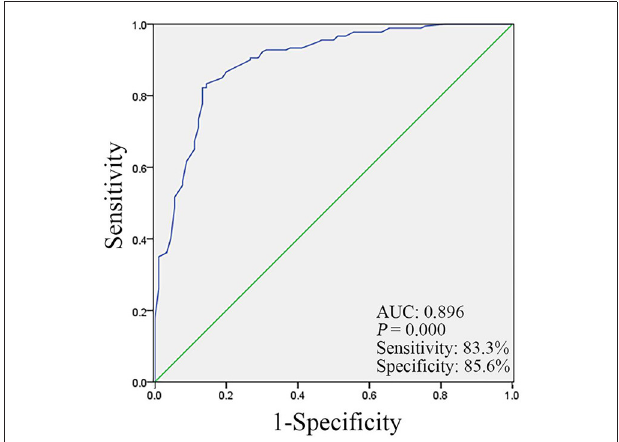
FIGURE 2 | The receiver operating characteristic (ROC) curve analysis for the education level, underlying diseases, living environment, and body mass index (BMI) value in the NTM group and control